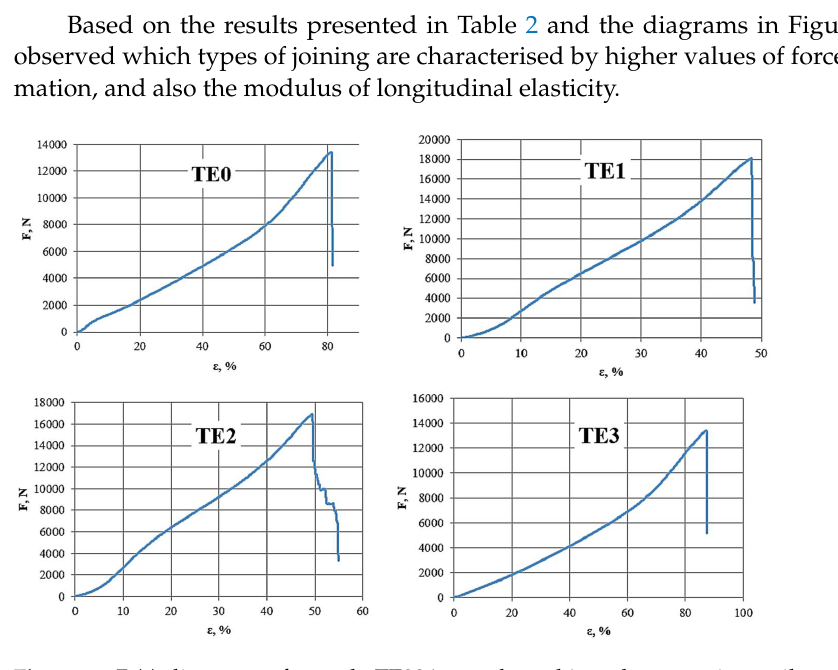
Figure 6. F ( ε ) diagrams of sample TE324 samples subjected to a static tensile test; Source: Own researches